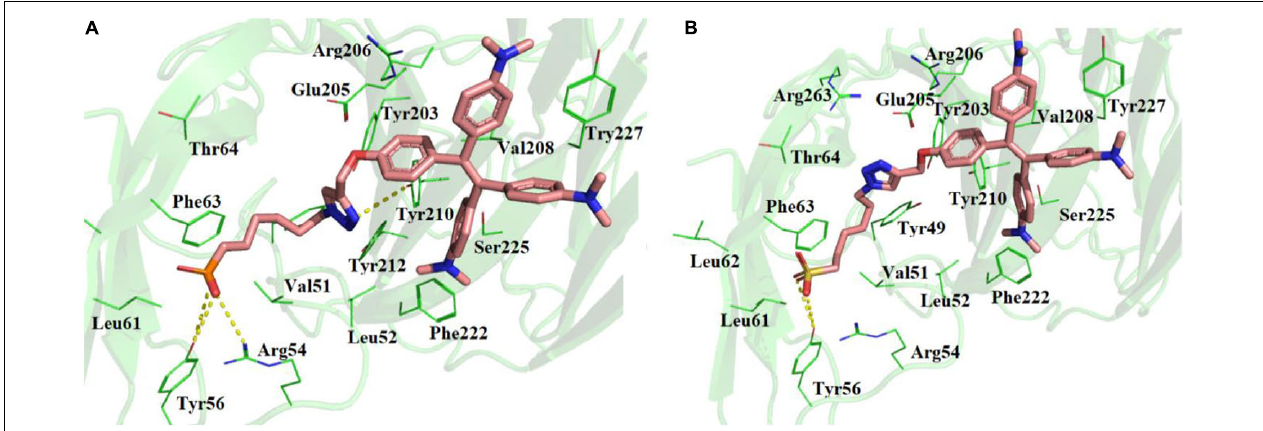
FIGURE 2 | Molecular docking of (A) TPE-P and (B) TPE-S in the active site of N-terminal domain of SARS-CoV-2 spike protein. The TPE-P and TPE-S molecules are shown in stick model and the amino acid residues are shown in line representation. The hydrogen bonds are shown in broken yellow lines.